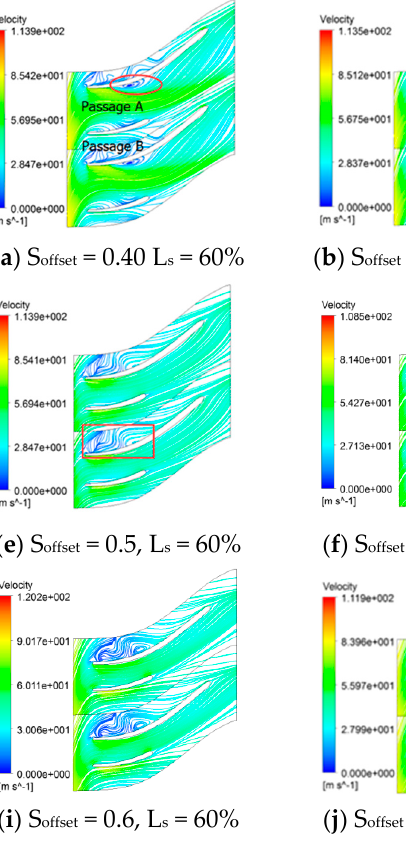
Figure 8. Streamline distribution when span = 0.5.